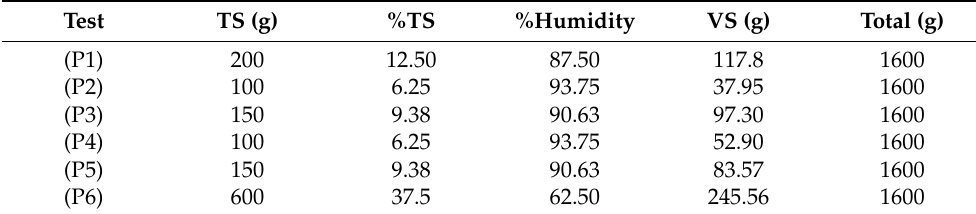
Table 2. Total values and percentage values of the solids and the humidity of the six tests.